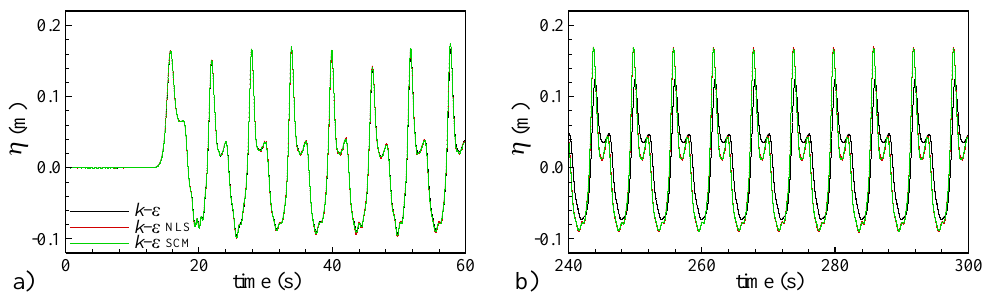
Figure 22. Time series of free surface elevation for k- ε , k- ε NLS and k- ε SCM turbulence models at the gauge x = 42.5 m (near the toe of the breakwater): ( a ) from 0 to 60 s, and ( b ) from 240 to 300 s.